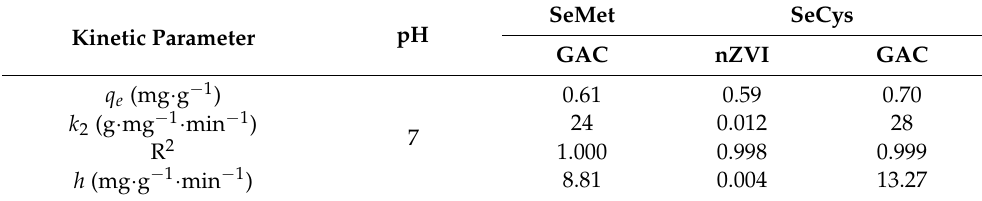
Figure 7. ( a ) Organic selenium adsorption kinetics using 7 g/L of GAC. ( b ) SeCys adsorption kinetics using 7 g/L of nZVI. All experiments were conducted at pH 7.0, 25 °C with an initial concentration of 5 mg/L. Table 4. Kinetic parameters of pseudo-second-order models for SeMet and SeCys